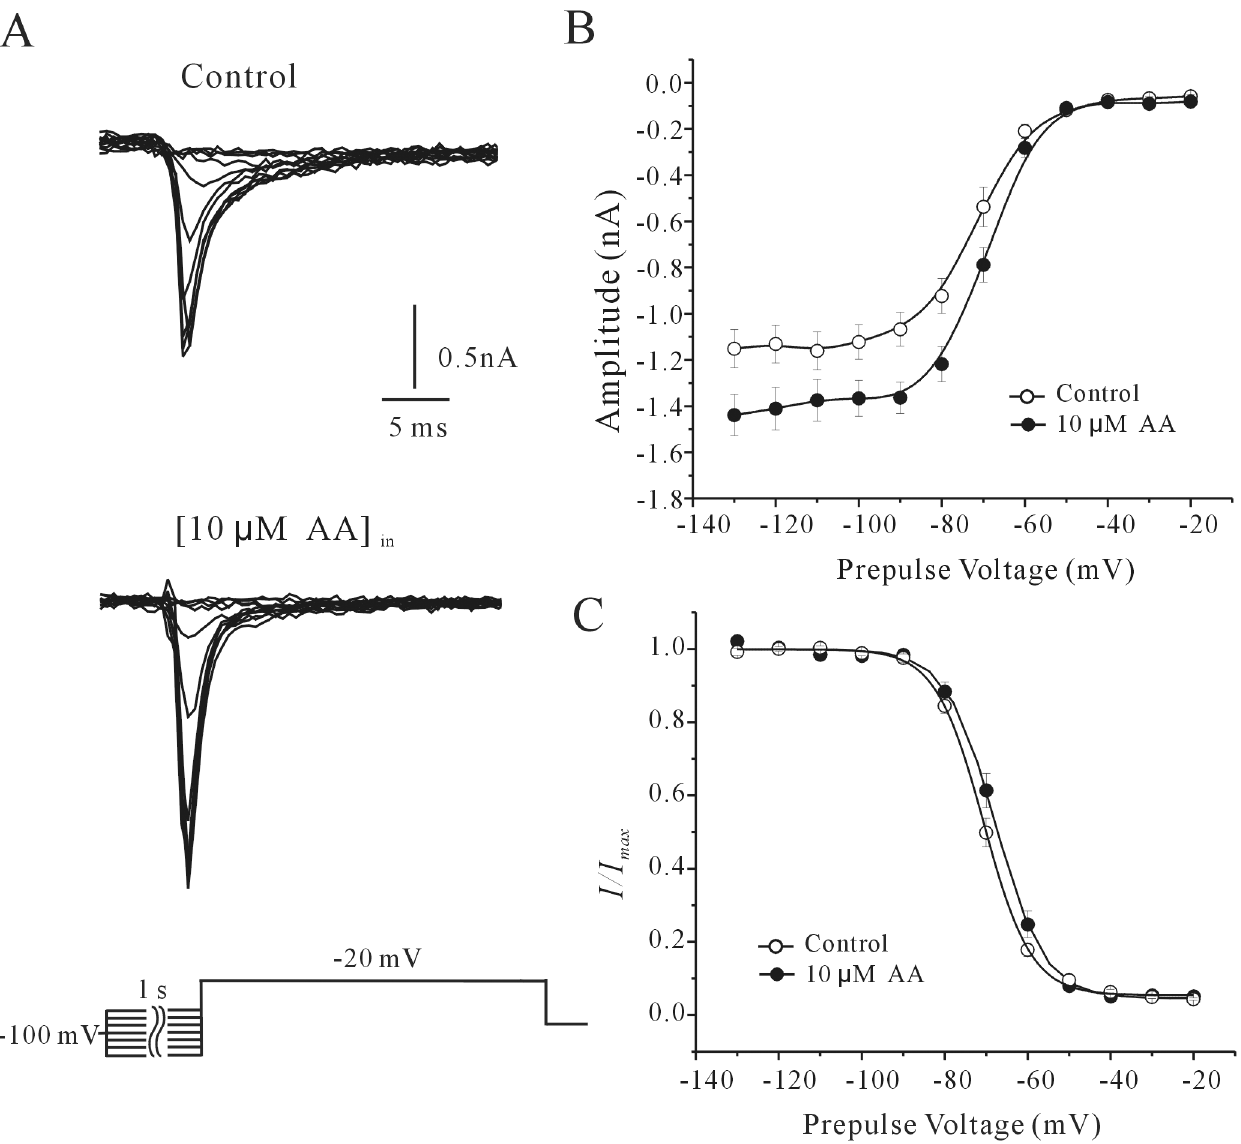
Fig 3. Effect of AA on the steady-state inactivation of rNa V 1.4 currents. (A) Control currents (top) and currents following the application of 10 μ M AA (bottom). Conditioning pre-pulses of 1s from -130 to -10 mV in increments of 10 mV were applied before the test pulse to -20 mV. The voltage protocol is shown below the current recordings. (B) Steady-state inactivation curves of rNa V 1.4 currents in the absence and presence of 10 μ M AA. The abscissa indicates the conditioning pre-pulse potentials. (C) Peak current amplitude normalized to the maximum current plotted against the pre-pulse potential. Normalized current points were fitted with the Boltzmann function I Na / I Na-max = 1/{1+exp[( V m – V m1/2 )/ k ]}+ A . Data were obtained from twenty-five cells and are expressed as mean ± S.E.M.